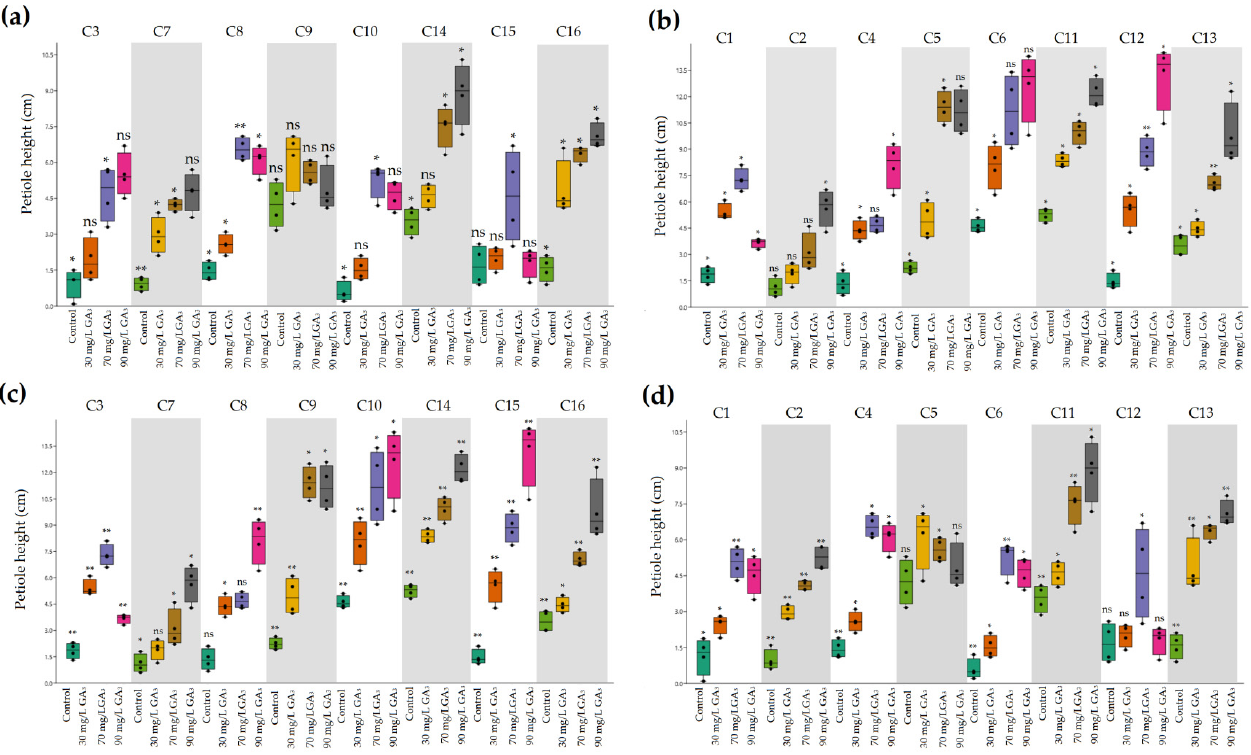
Figure 2. The effects of ambient temperature and high temperature stress and exogenously applied GA 3 on petiole height of heat-tolerant ( a , c ) and heat-sensitive ( b , d ) genotypes. * Significant at 5% probability level; ** significant at 1% probability level; ns, no significant difference.